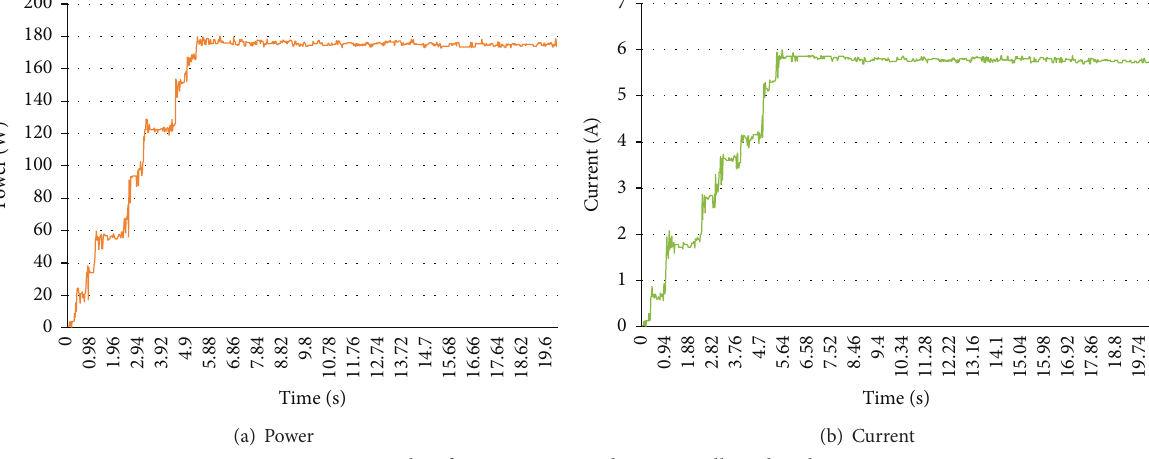
Figure 13: Experiment results of output power and current collected in the upper computer.